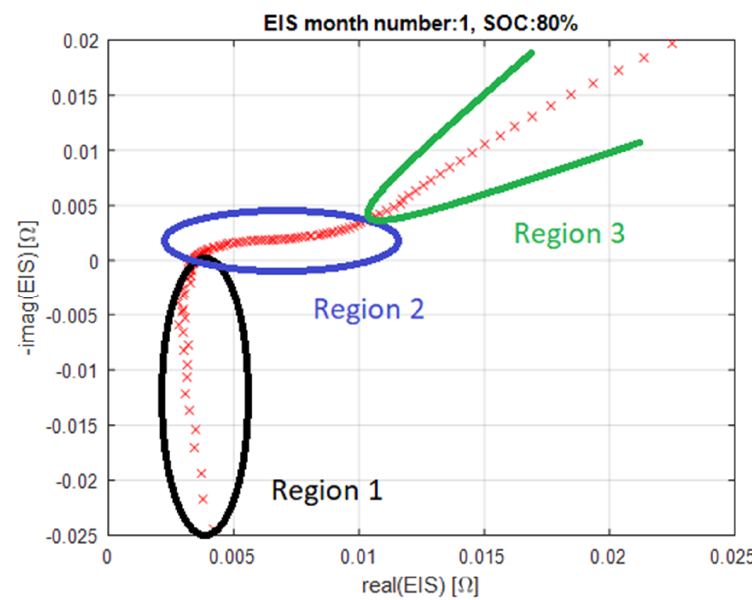
Figure 3. 80% SoC EIS experiment in first iteration (Pristine Battery).